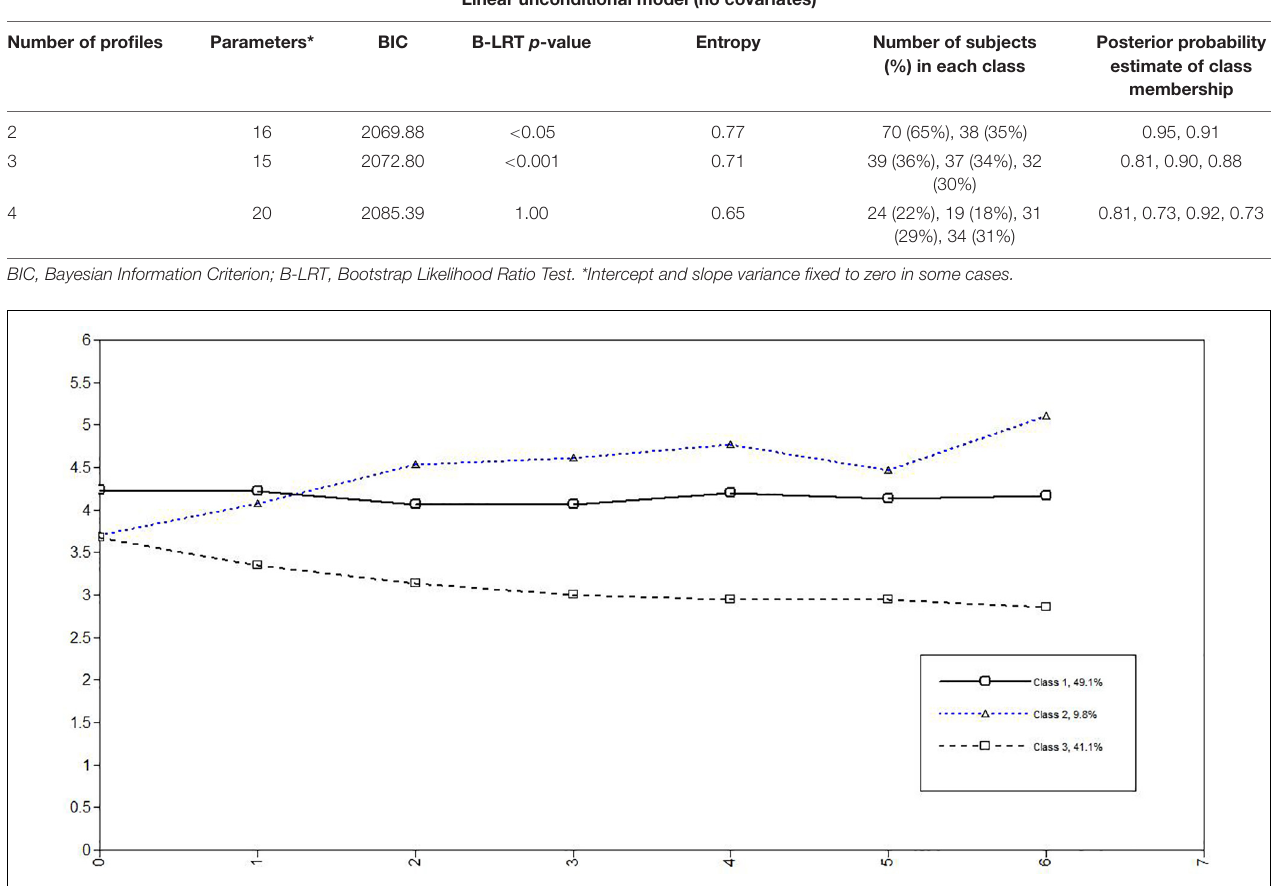
Increasing PA class probability is lowered by high reappraisal values, relative to Constant High PA class. On the contrary, this regulation strategy did not show any effect on Decreasing PA